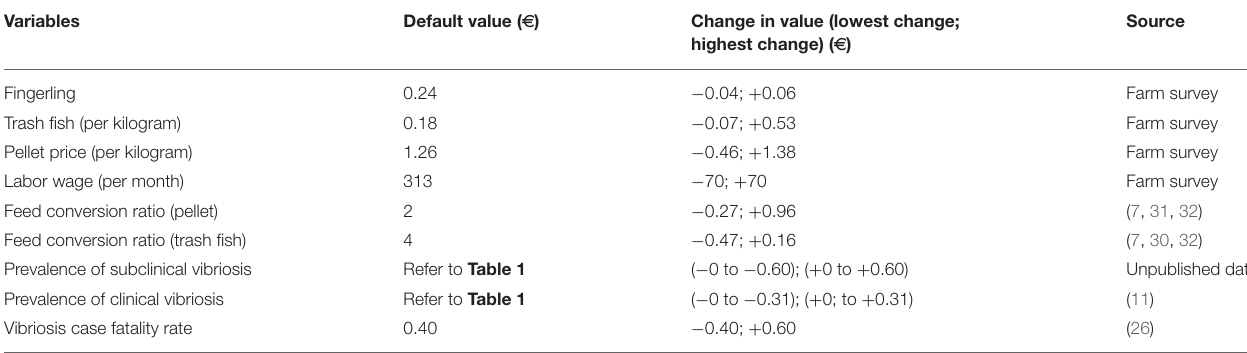
TABLE 6 | Sensitivity analyses for biological and economic inputs.